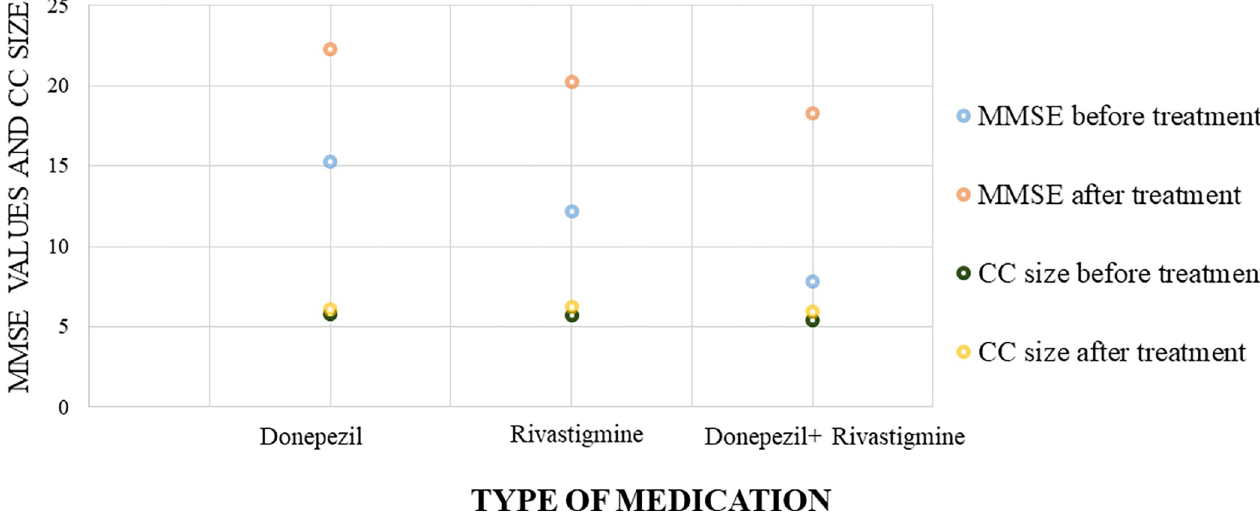
Fig 6. A scatter plot show the mean CC improvement versus mean MMSE score improvement for each medication. The scotter plot showed that MMSE score improvement was assocaiated with increase in CC size, moreover, using a using combined therapy with donepezil and rivastigmine gives a better improvement in both MMSE score and CC size compared with a single medication.